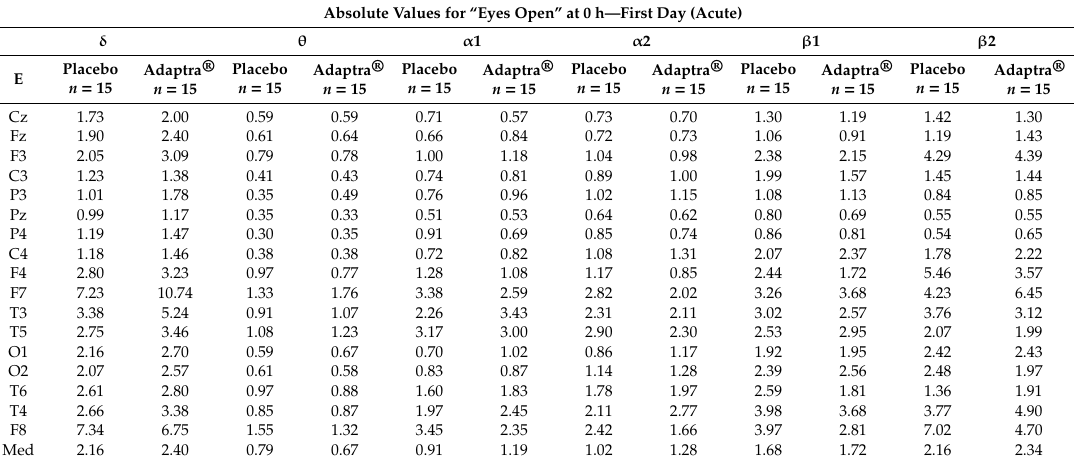
Table 2. Absolute spectral power of baseline as recorded with eyes open. δ = delta, θ = theta, α 1